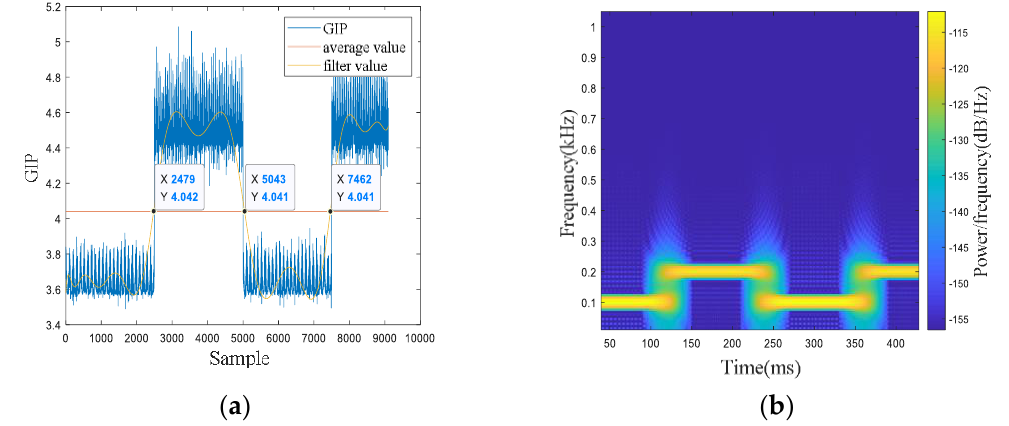
Figure 7. ( a ) Generalized inner product value of each sample, and ( b ) time – frequency analysis result of simulation data.